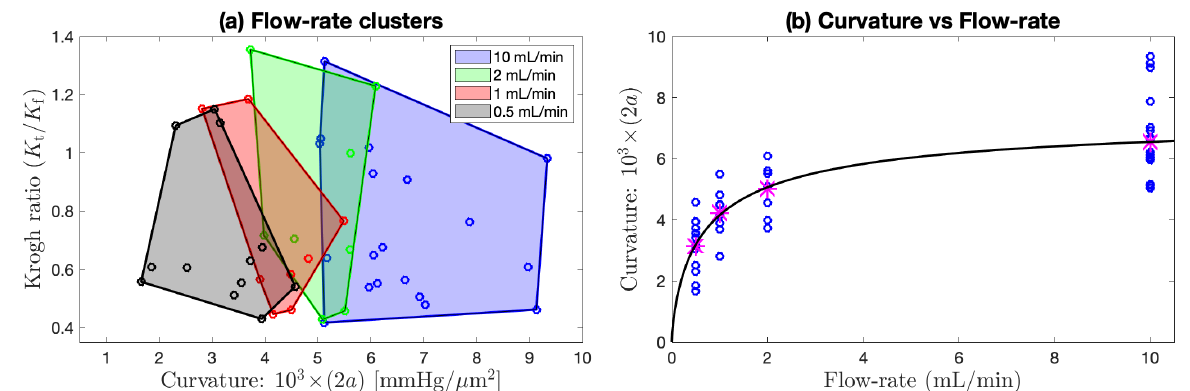
Figure 8. Flow rate clustering and curvature dependence aggregated across (lower interface) of Figure 7d–f. ( a ) Aggregated scatterplot of candidate Krogh ratio ( K t / K f ) vs. curvature of fitted parabolic/paracosh function, clustered by flow rate [10, 2, 1, or 0.5] mL/min, as indicated by shaded convex-hull polygons (computed via M ATLAB function convhull ). Qualitatively, the poly- gon centroids move to the left as flow rate decreases, implying that curvature decreases (profiles become flatter) as perfusion flow rate is reduced. This trend is made quantitative in ( b ) with a sigmoid fit to the Table 4 curvature means (magenta asterisks) at each flow rate. The fitted curve is y = y max · x n / ( K n + x n ) with [ y max = 7.5 × 10 − 3 mmHg/ µ m 2 ; K = 0.75 mL/min; n =